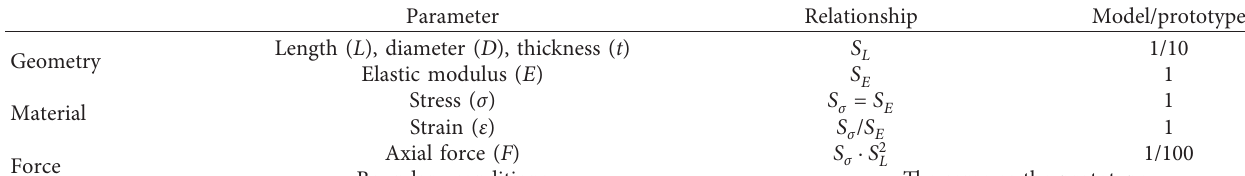
Table 1: Similitude scale factors for present test specimen.